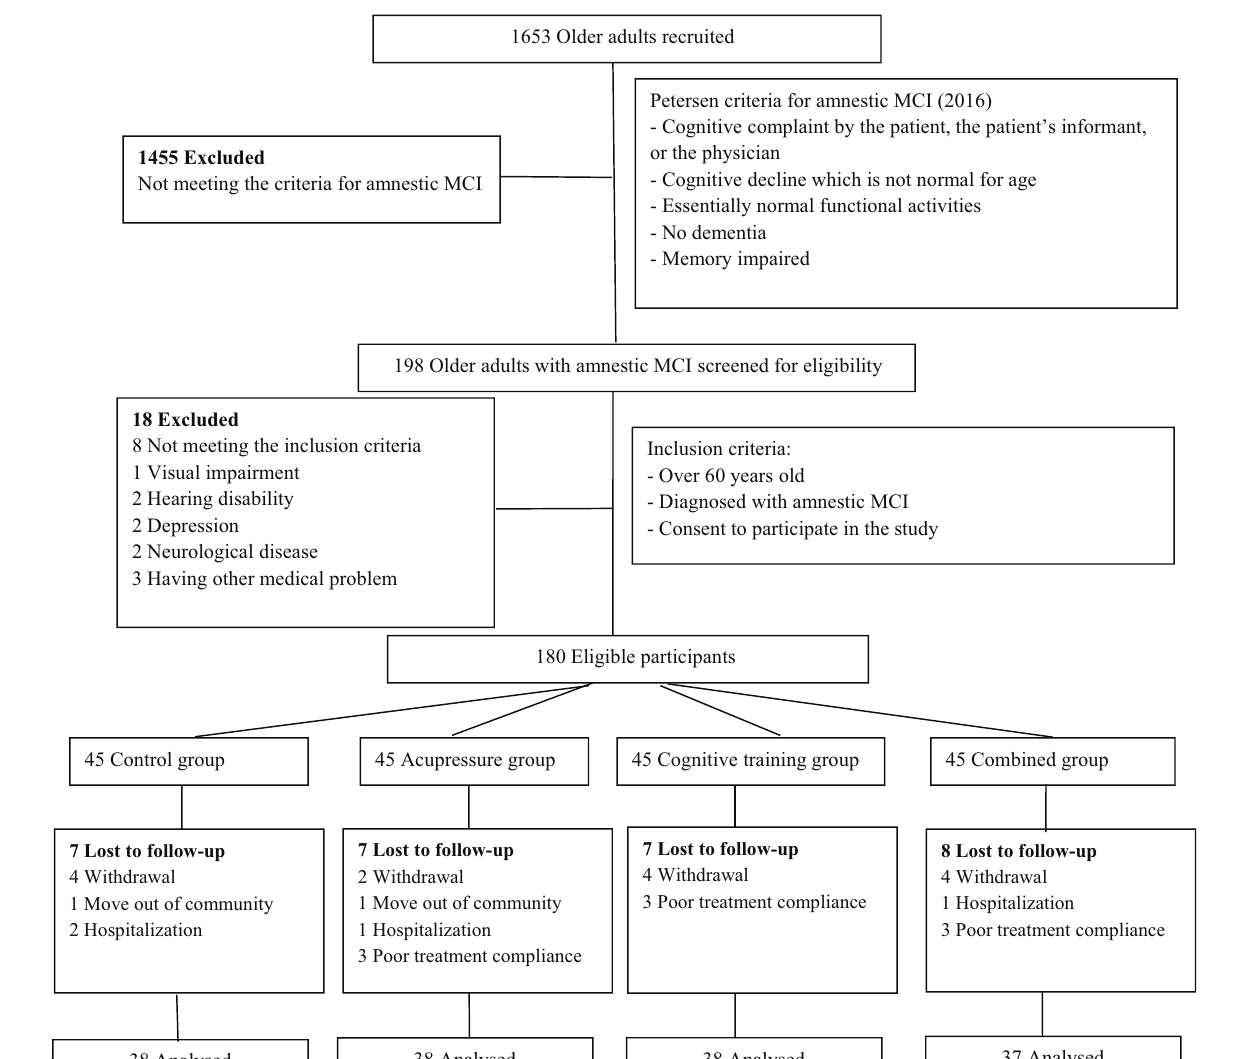
FIGURE 2 | Flow chart showing participants in each group throughout the trial.